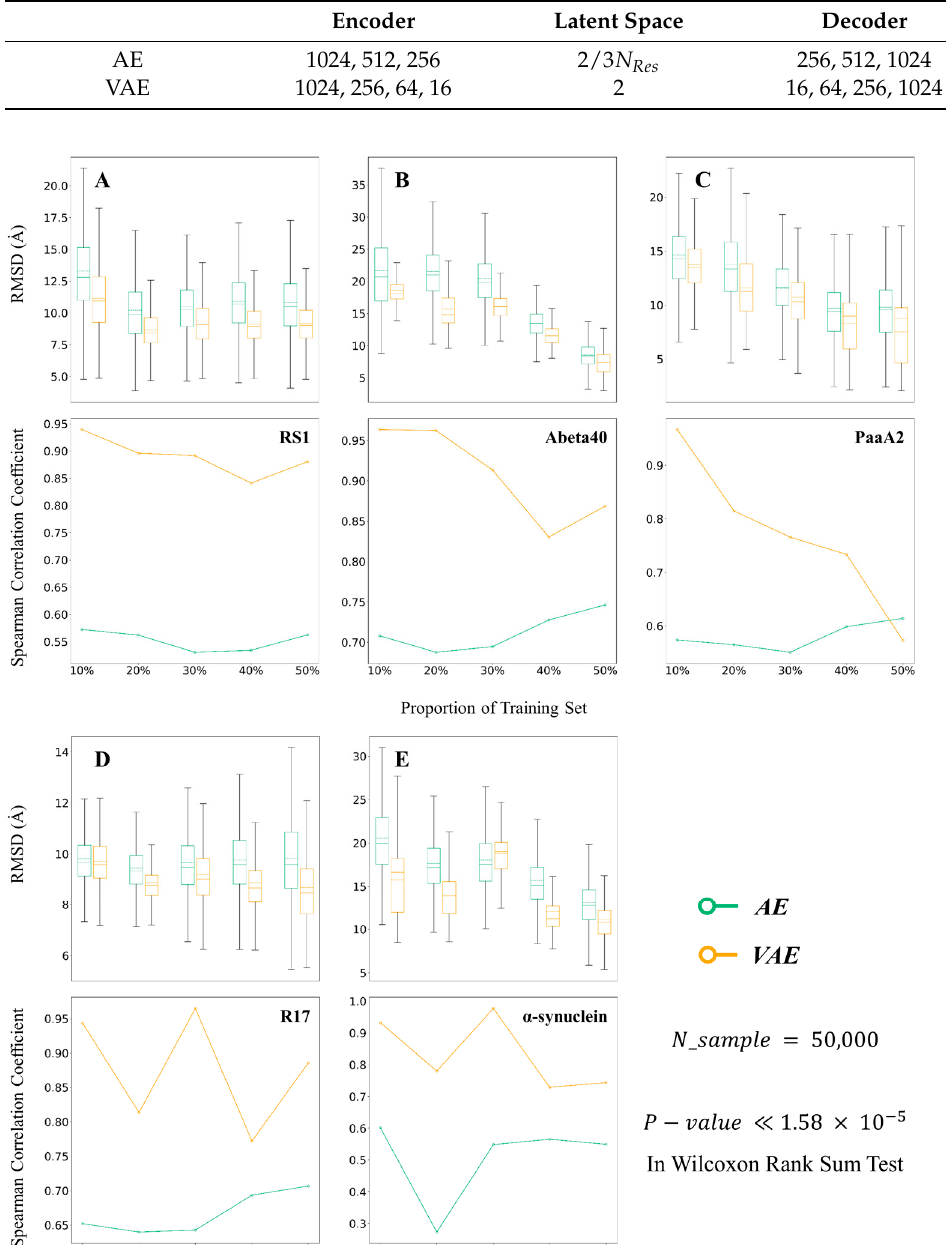
Figure 1. RMSDs and the Spearman correlation coefficients between VAE- or AE-generated IDP conformations and original ones. Dashed lines in boxplots represent mean RMSD. Here, both models are trained on 10% to 50% of conformations separately and are evaluated on the test set. ( A ) RS1. ( B ) Abeta40. ( C ) PaaA2. ( D ) R17. ( E ) α -synuclein.